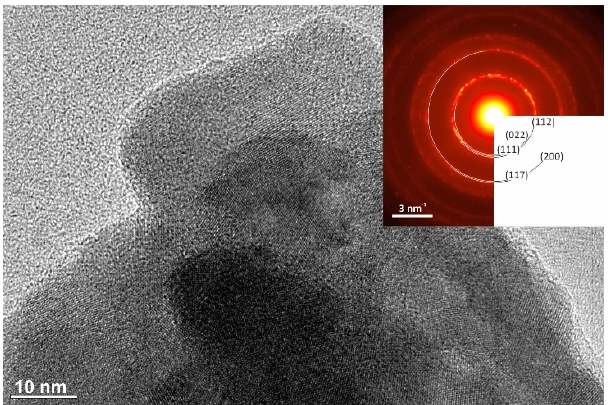
Figure 6. HRTEM image of agglomerated crystals of sample CuSe-PM, imaged at magnification 300 kx, SAED pattern of the same crystals (inset).